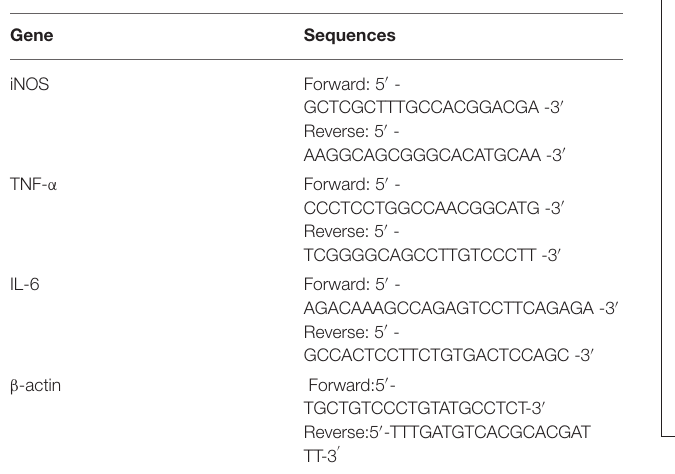
TABLE 1 | Primers for reverse transcription-PCR (RT-PCR).